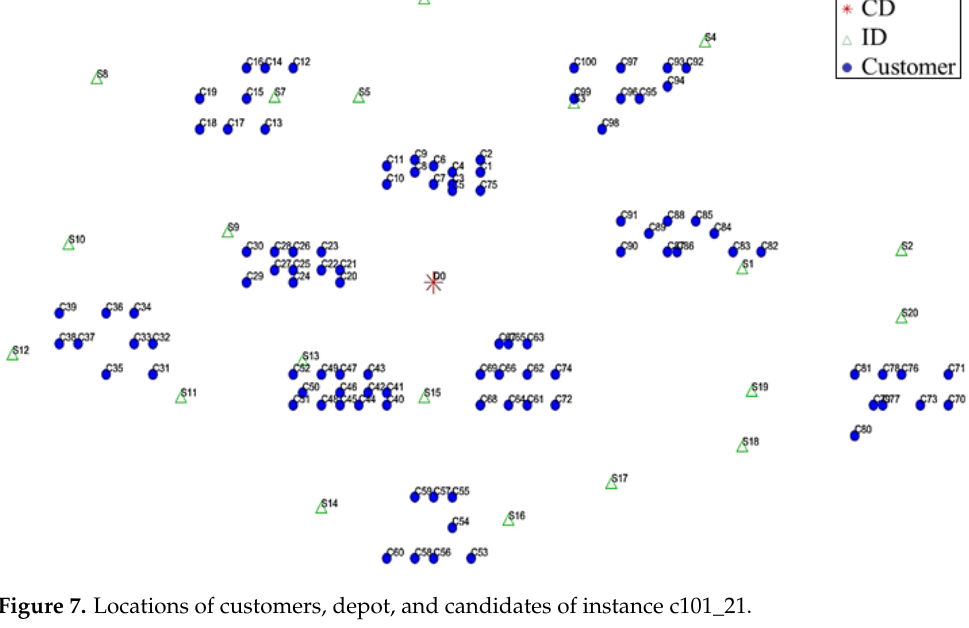
Figure 7. Locations of customers, depot, and candidates of instance c101_21.